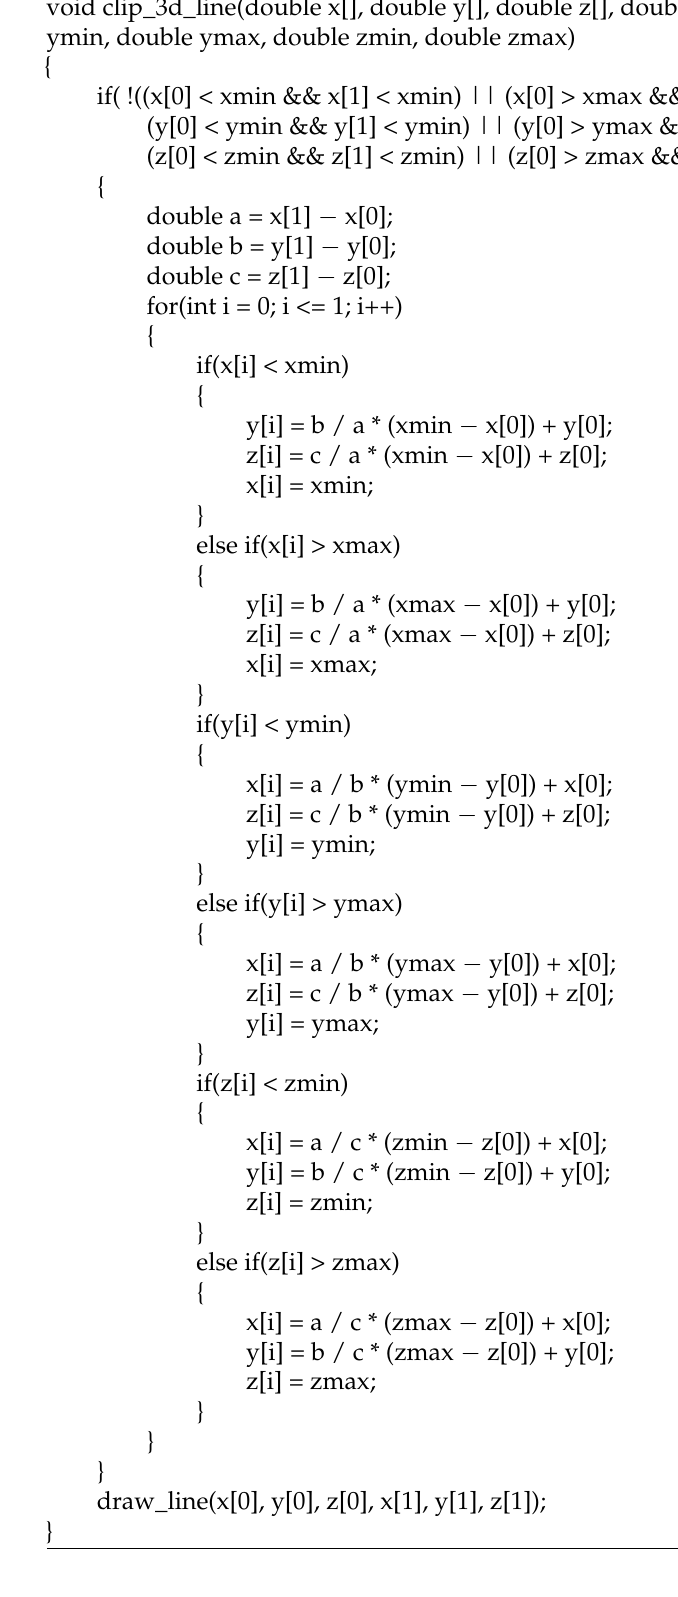
Algorithm 1 The proposed